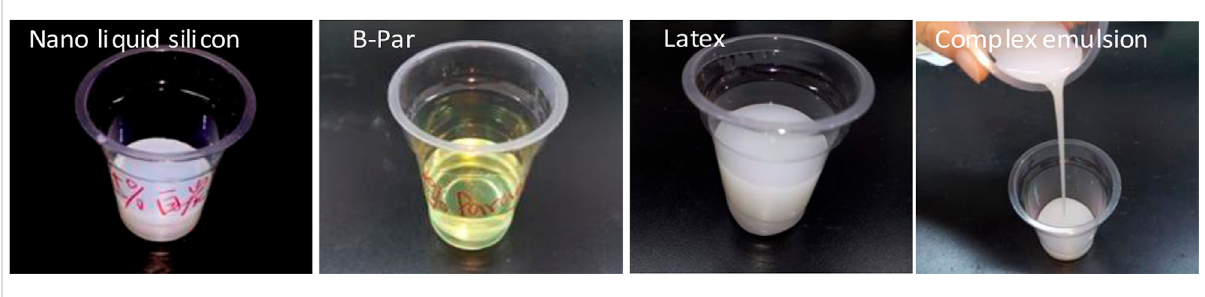
FIGURE 3 Composition and state of compound